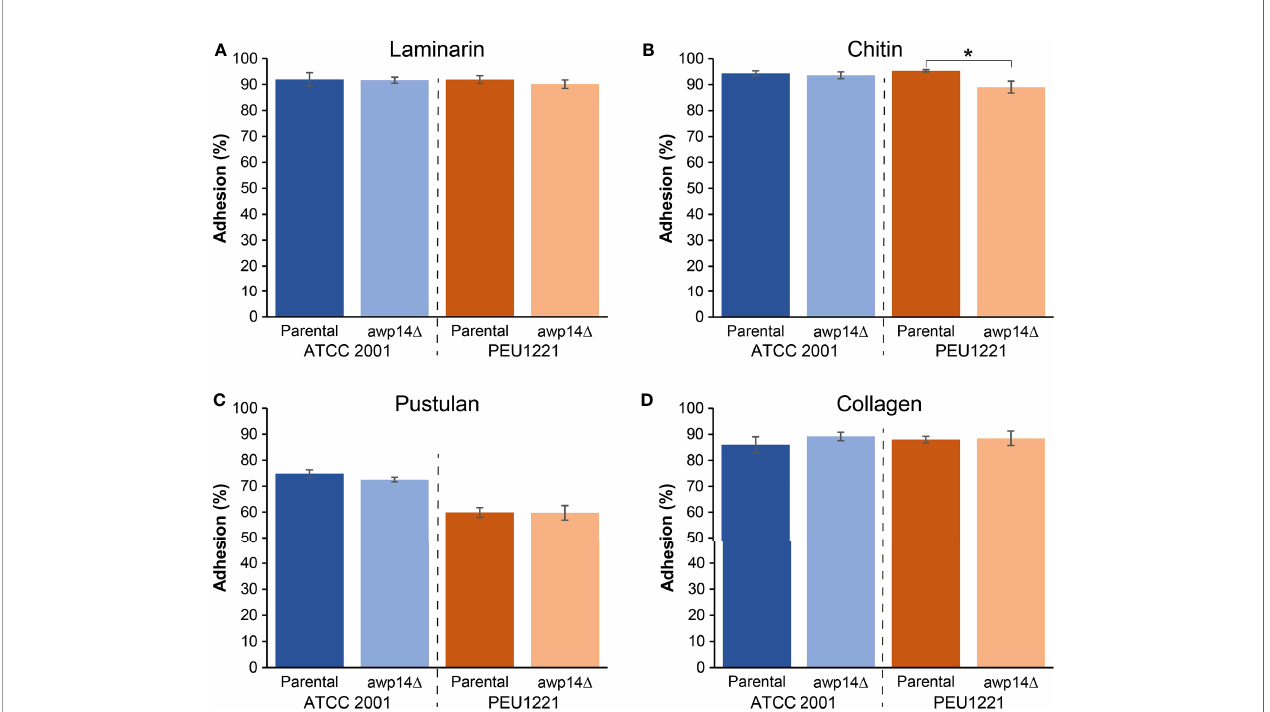
FIGURE 3 | Deletion of AWP14 results in a slight reduction of HBF strain PEU1221 binding to chitin. Binding to fungal cell wall ( b -1,3-glucan, b -1,6-glucan, and chitin) and mammalian extracellular matrix (collagen) molecules was measured by fl ow cytometry after incubating C . glabrata cells for 4 h in microtiter plates containing pre fi xed layers of (A) laminarin ( b -1,3-glucan), (B) chitin, (C) pustulan ( b -1,6-glucan), and (D) collagen. The statistically signi fi cant difference in chitin binding between PEU1221 and mutant is indicated by an